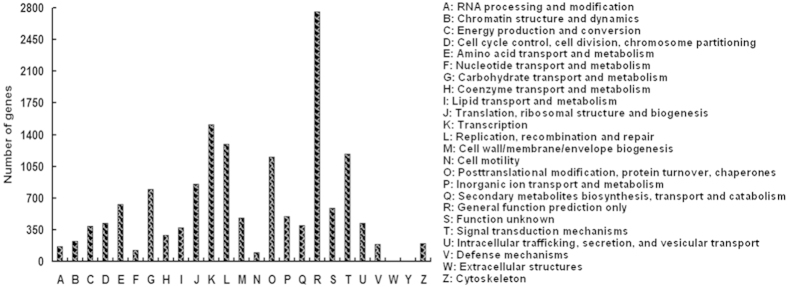
Histogram for COG classification of the assembled unigenes.